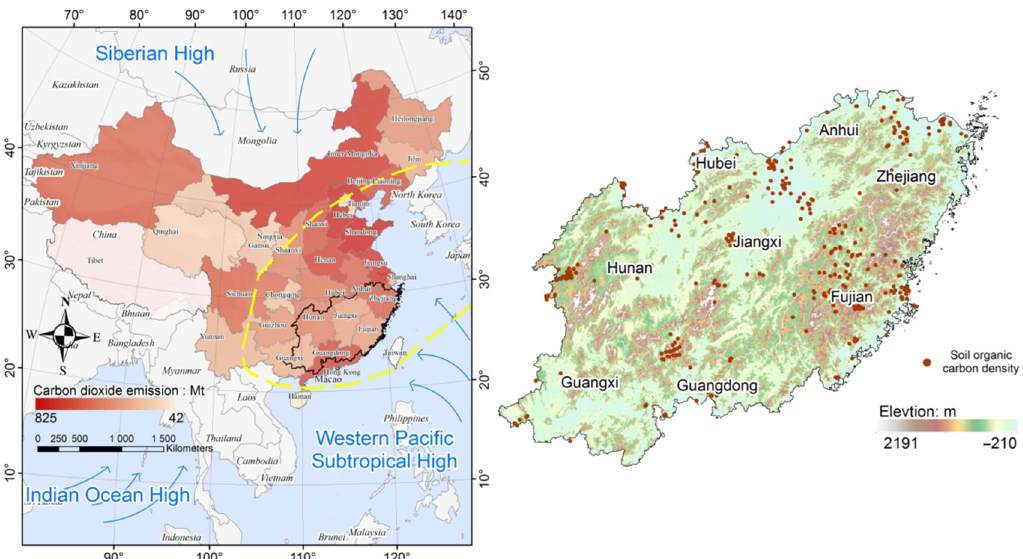
Figure 1. Location map of the RSHR in China (spatial distribution of the CO 2 emissions (Mt) of China by province in 2015; data from Oak Ridge National Laboratory (https://cdiac.ess-dive.lbl.gov/, accessed on 4 December 2015). The yellow circle represents the East Asian monsoon region. The blue arrows represent the Western Pacific subtropical high, Siberian high and Indian Ocean high. The red points represent the SOC density and its spatial location in the implementation area of the ERPs in the RSHR.